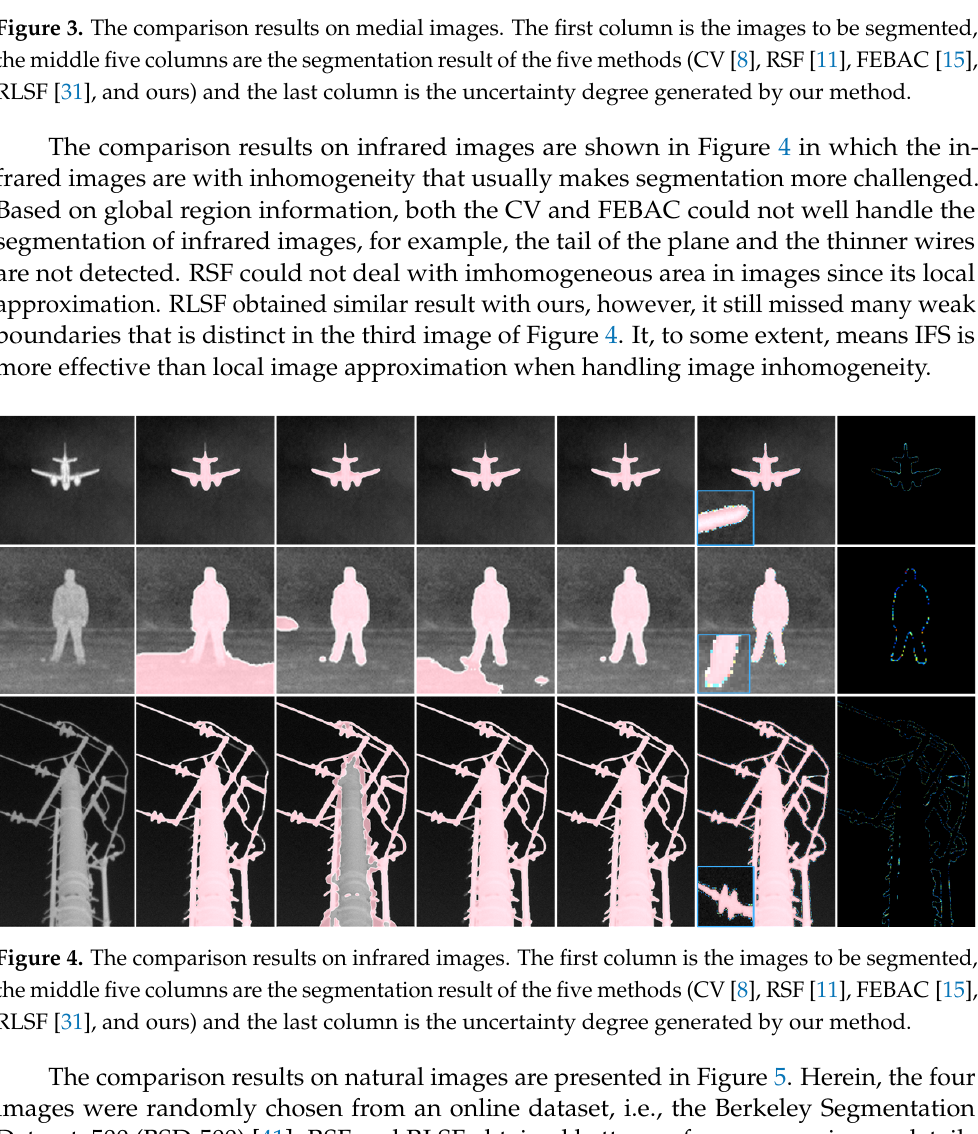
frared images are with inhomogeneity that usually makes segmentation more challenged.